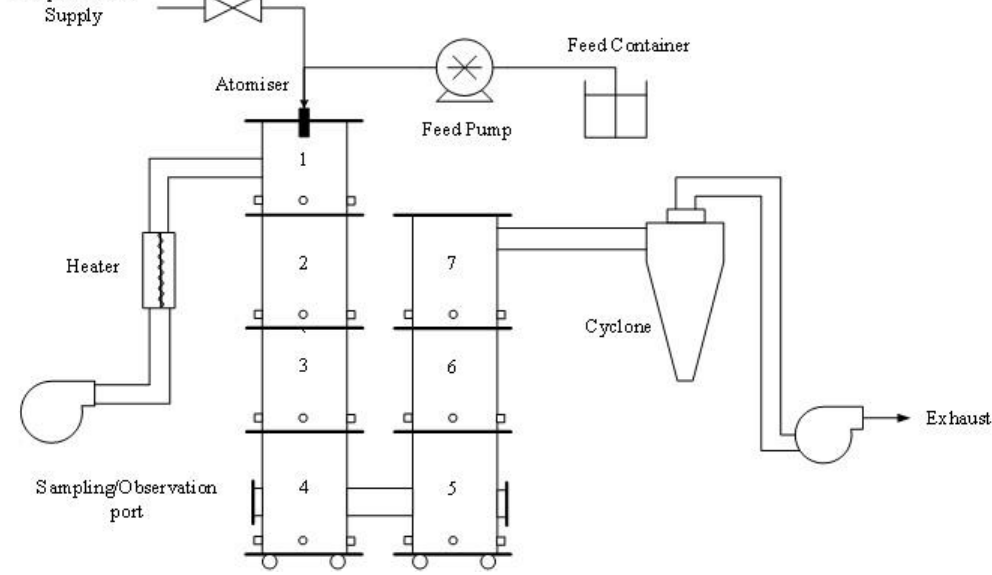
Figure 3. Schematic diagram of the spray-drying system, four-inch (100 mm) configuration.